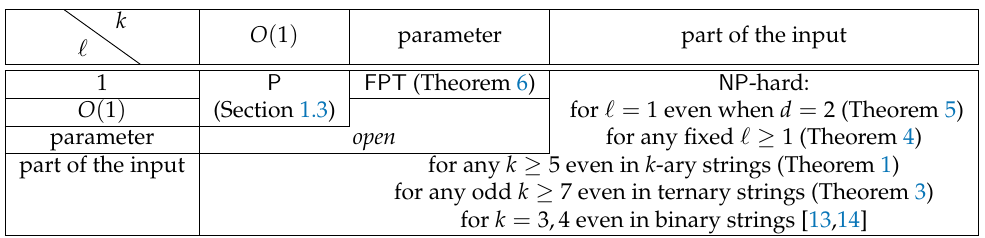
Table 1. Summary of the results for S ORTING BY M ULTI -C UT R EARRANGEMENTS in strings. Recall that d denotes the maximum number of occurrences of any character in the input string S